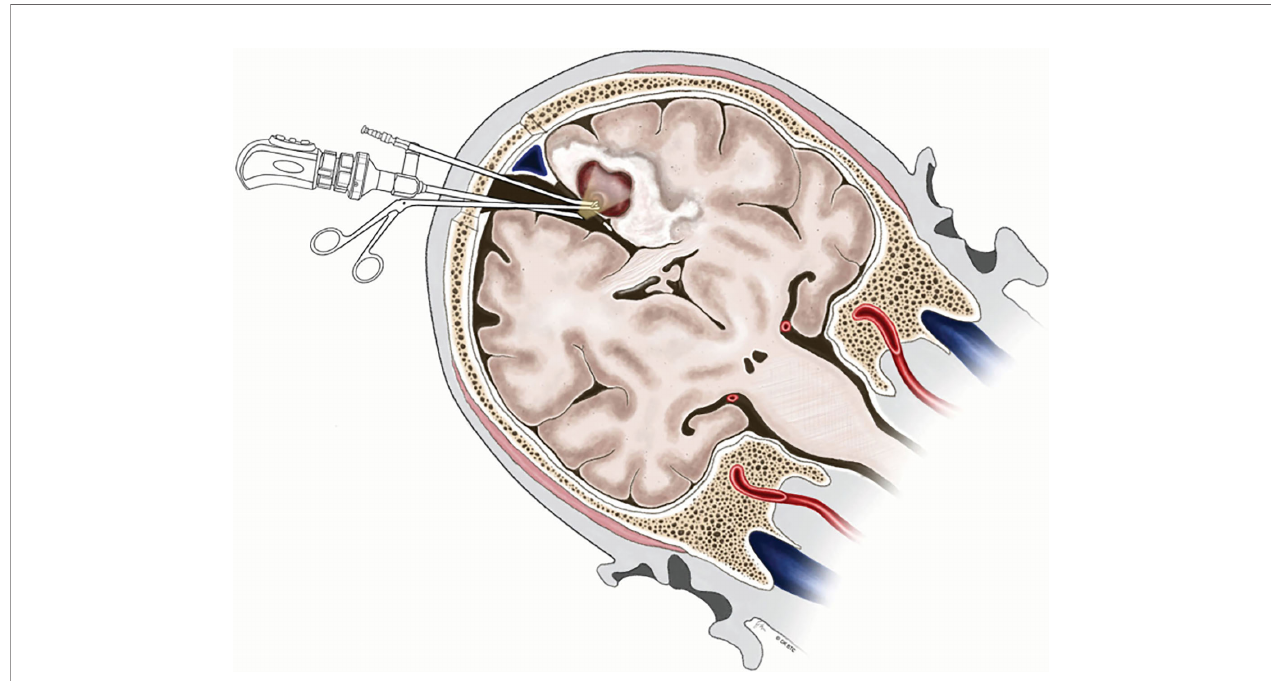
FIGURE 4 | Illustration demonstrating endoscopy-assisted gravity-aided contralateral transfalcine approach for deep medial BM involving the paracentral lobule. BM, brain metastases. From Barkhoudarian et al. (76).